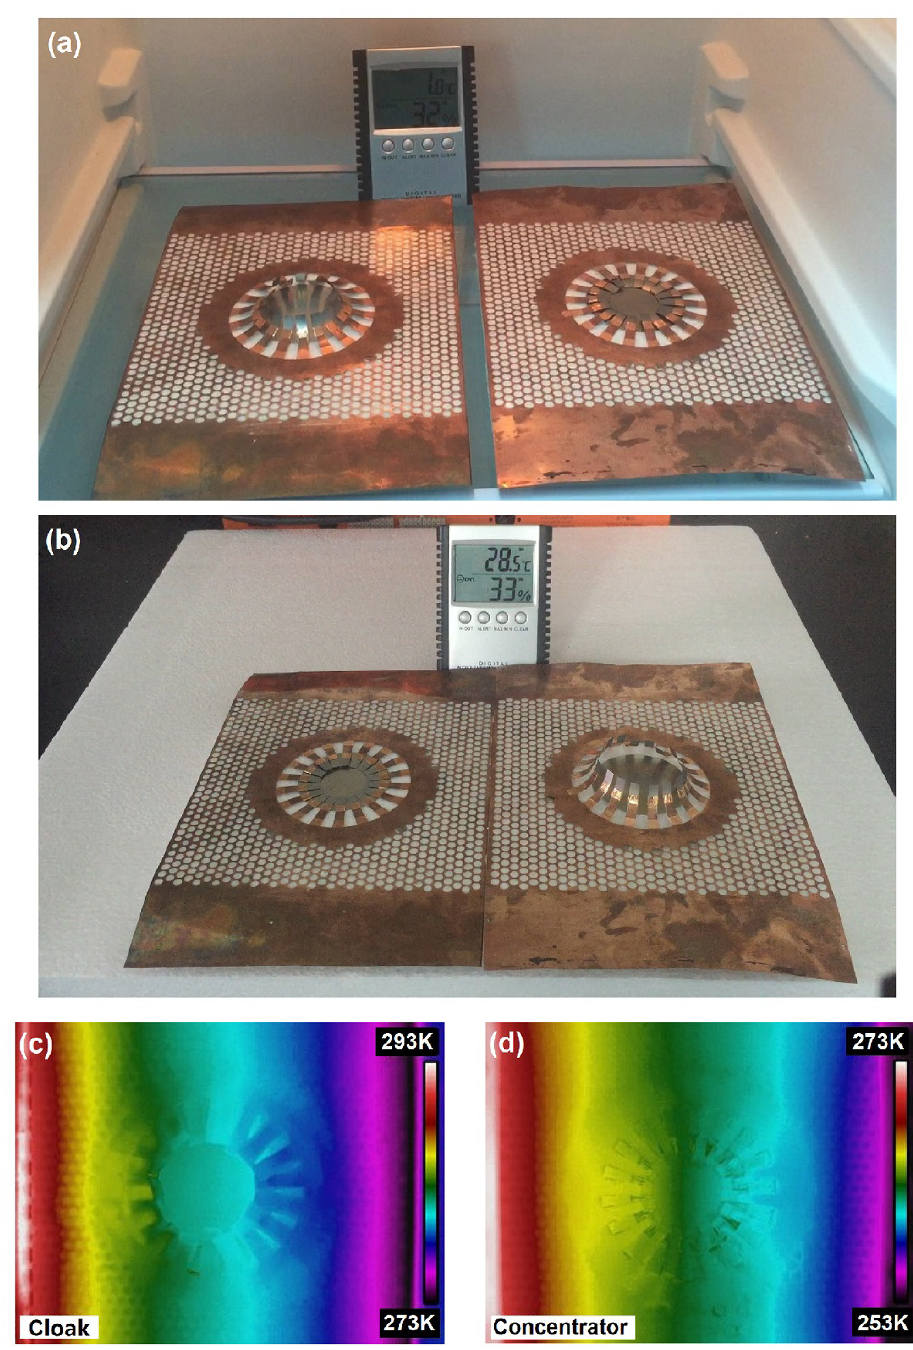
Figure 4. ( a , b ) are the photograph of the fabricated device. The device are constructed by using two different types of SMAs: one is flattened at 5 ◦ C and tilts up at 25 ◦ C; the other one is flattened at 25 ◦ C and tilts up at 5 ◦ C. ( c ) shows the temperature image of the cloak state captured by infrared thermal imager and ( d ) gives the temperature distribution of the concentrator